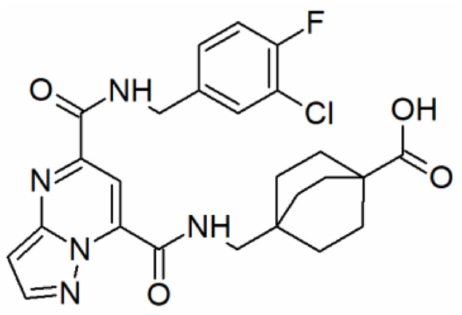
Figure 8. Chemical structure of MMP-13 inhibitor (MMP13i-A)